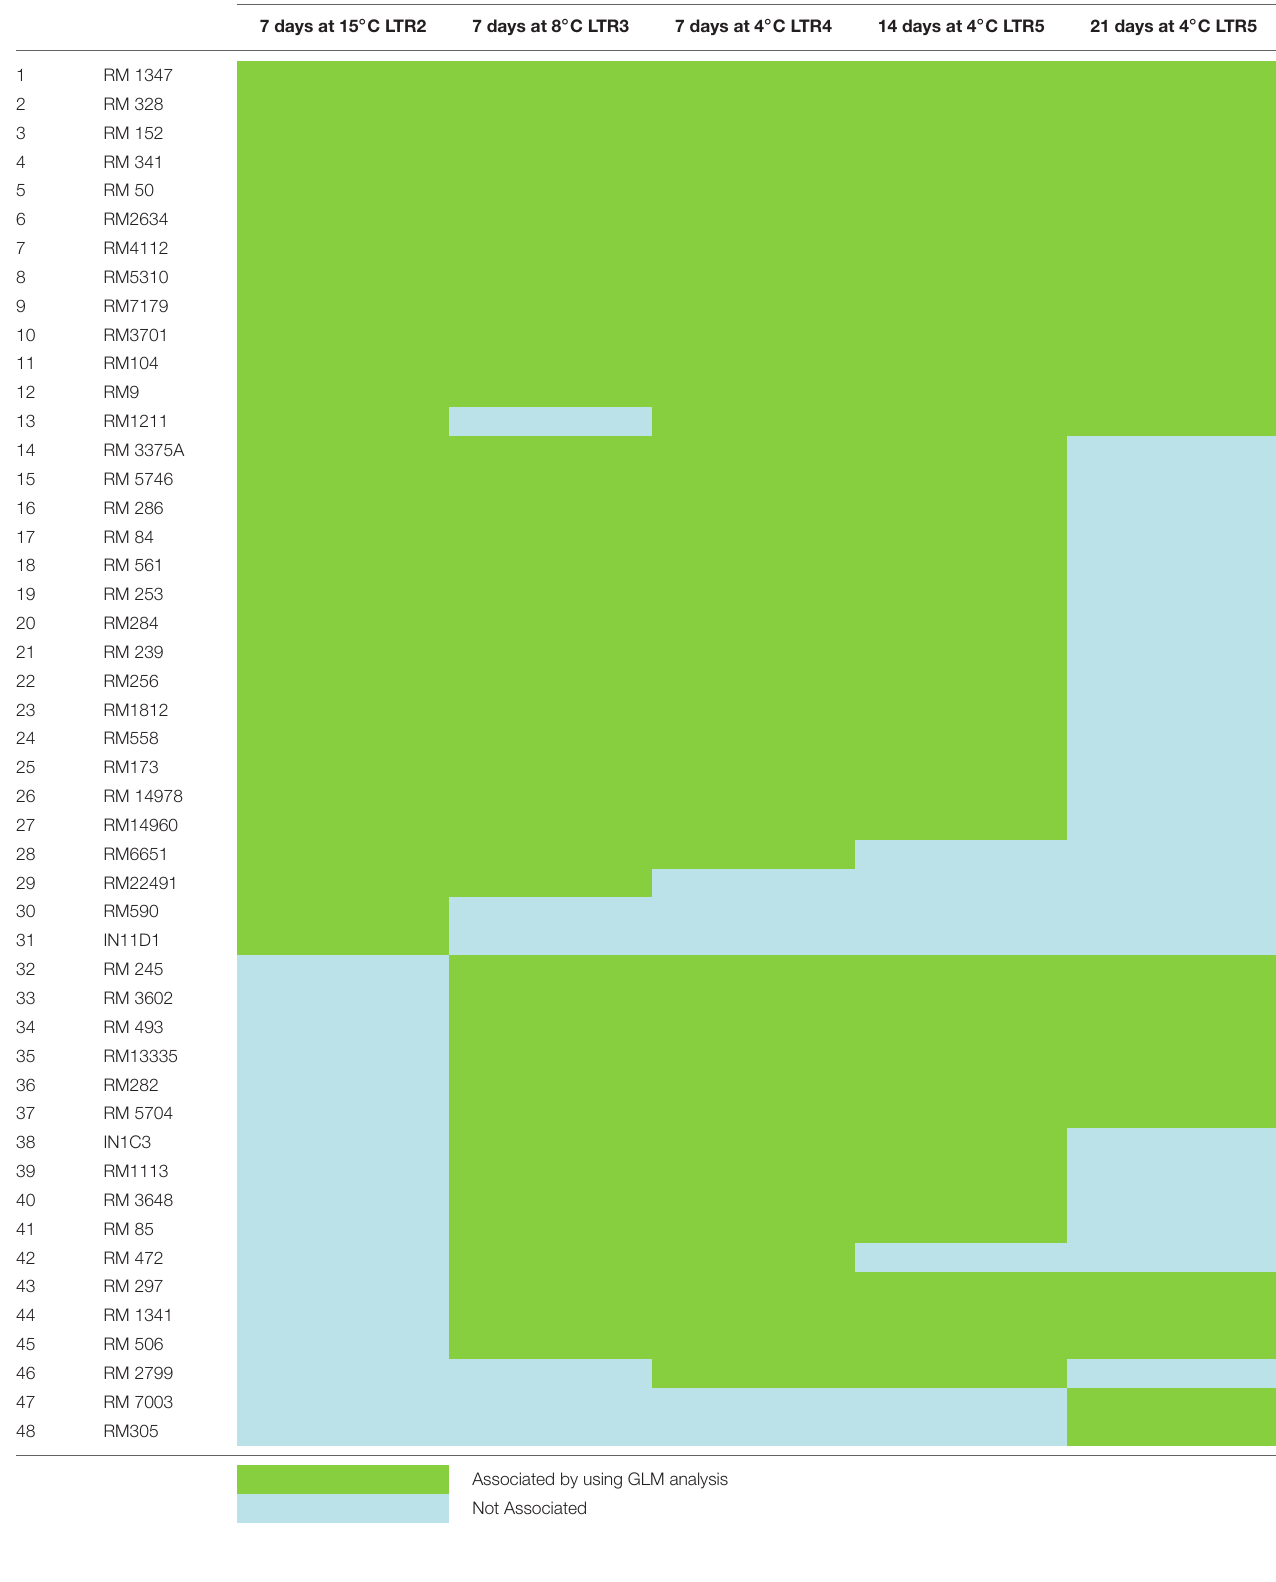
TABLE 7 | Association of markers with cold stress at different temperature regimes and durations by using GLM model at p < 0.05 and r 2 > 0.05. Sl